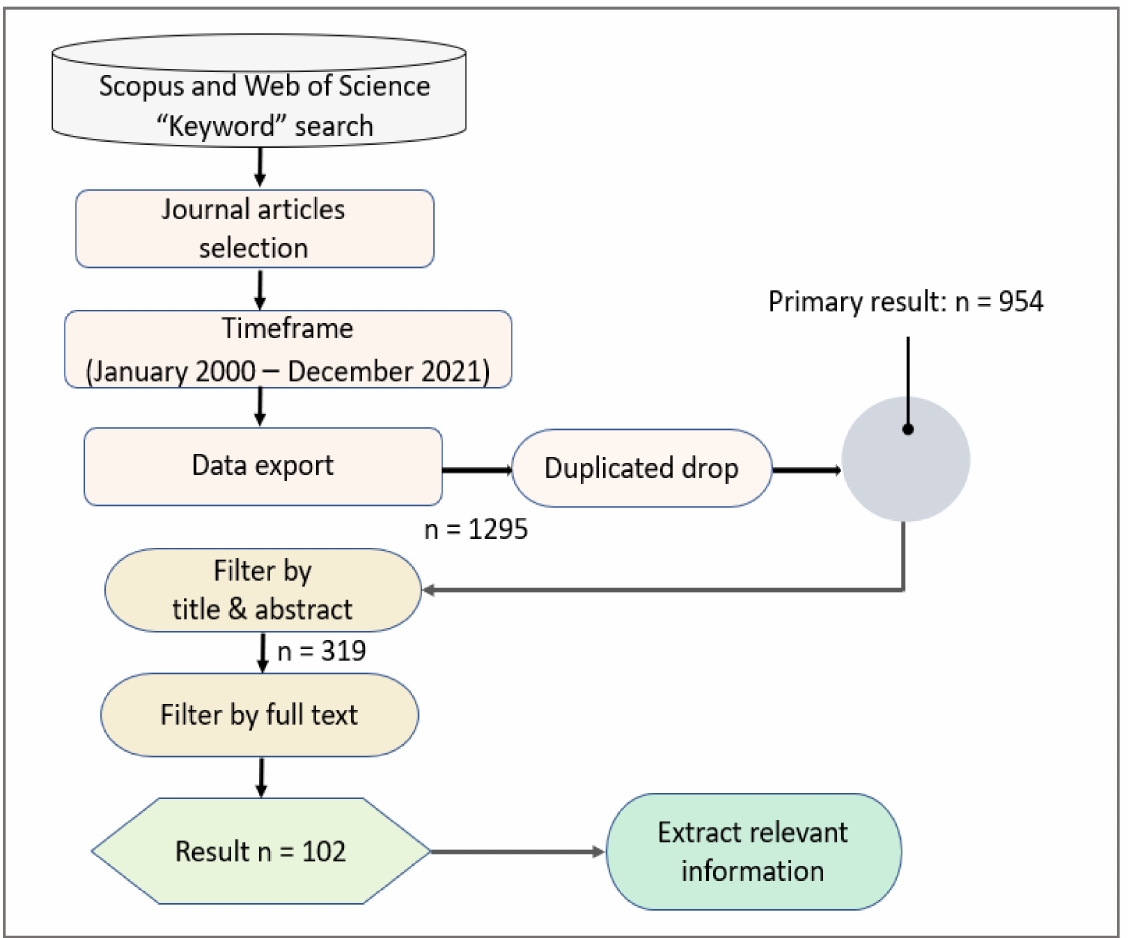
Figure 2. The simplified diagram describes the process from the keyword search to the final article selection. The details of the keyword and article selection are presented in the